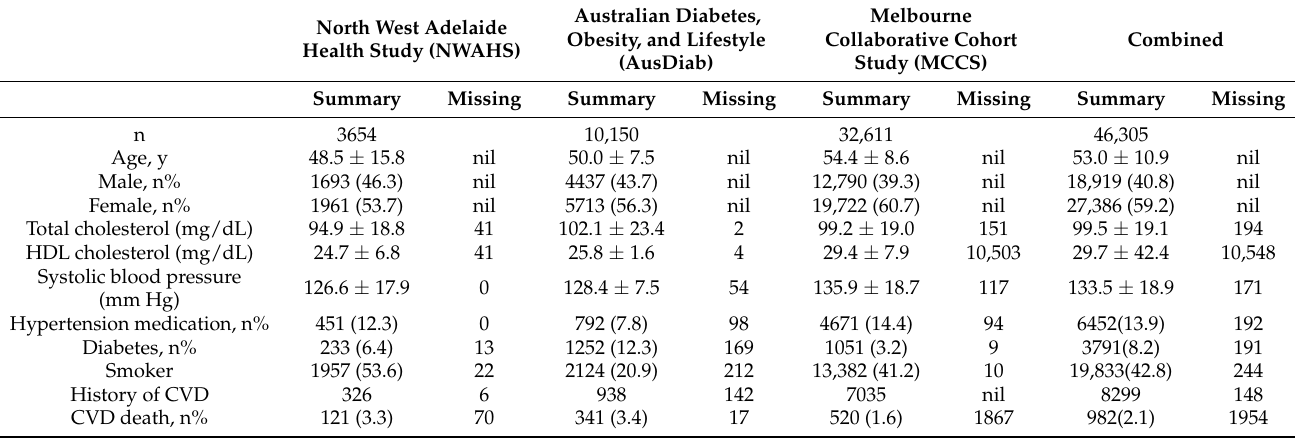
Table 2. Missing numbers and summary data (mean ± standard deviation) for the three-study cohorts and combined cohort. The values for n, age, male, female, total cholesterol, HDL cholesterol, systolic blood pressure, hypertension medication, diabetes, and smoker were input after removing CVD history and death, missing data, and imputation of other missing risk factor